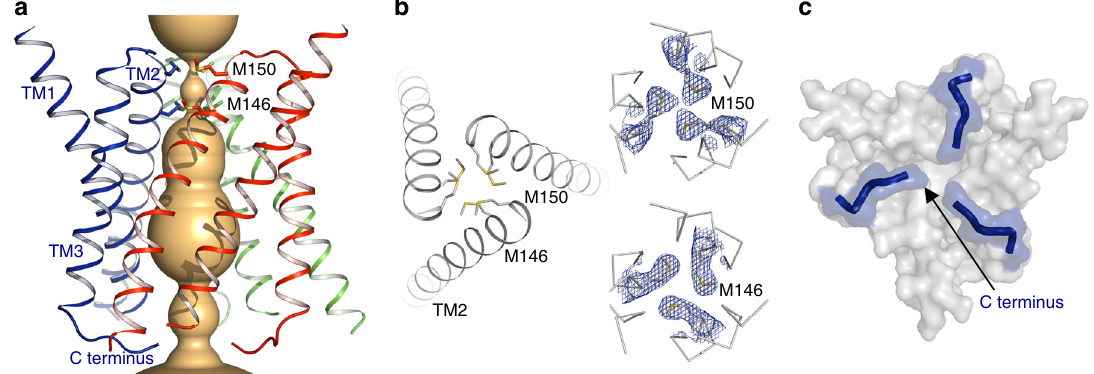
Fig. 3 Ion conduction pore. a The central ion conduction pore of sCtr1, shown as orange surface. b The Cu + selectivity fi lter. Two methionine rings (M146 and M150 in TM2) close to the extracellular side form the selectivity fi lter (left panel). The re fi ned 2F o − F c electron density for the methionine side chains (contoured at 1.7 σ ) is shown as blue meshes (right panels). c A hypothetical intracellular gate. Shown is the surface representation of sCtr1 from the intracellular side. The C-terminal tail following TM3 extends to the central pore axis, potentially forming an